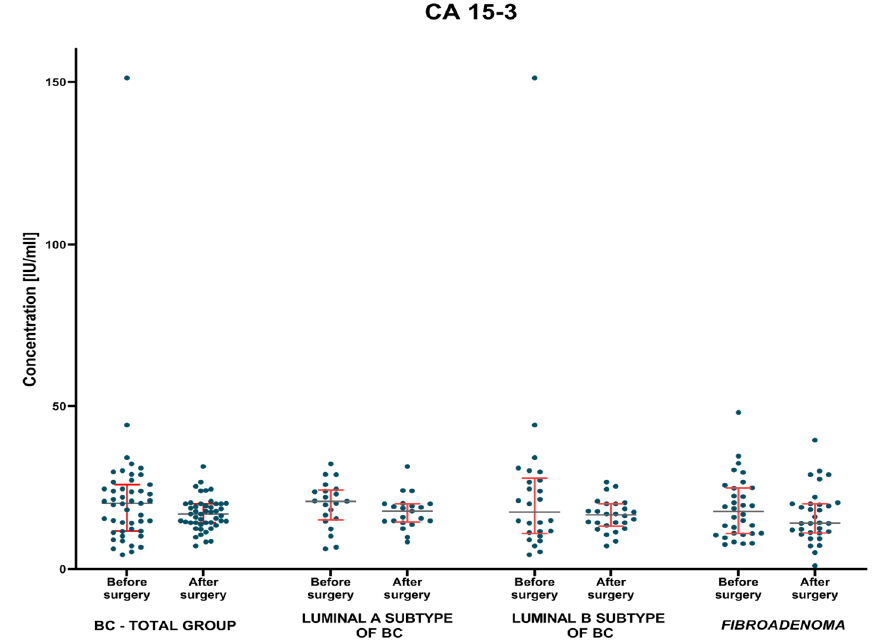
Figure 6. CA 15-3 plasma concentrations (with marked median and interquartile range) in patients (total group and subgroups) with BC and fibroadenoma subjects before and after surgery. (total group and subgroups) with BC and fibroadenoma subjects before and after